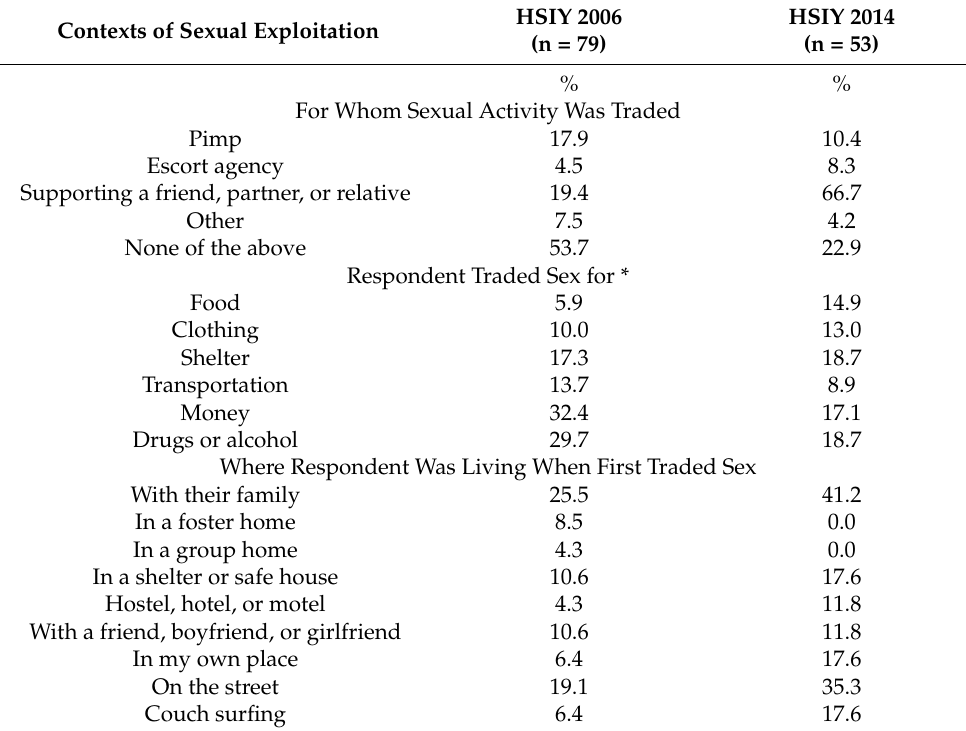
Table 3. Description of how sex was